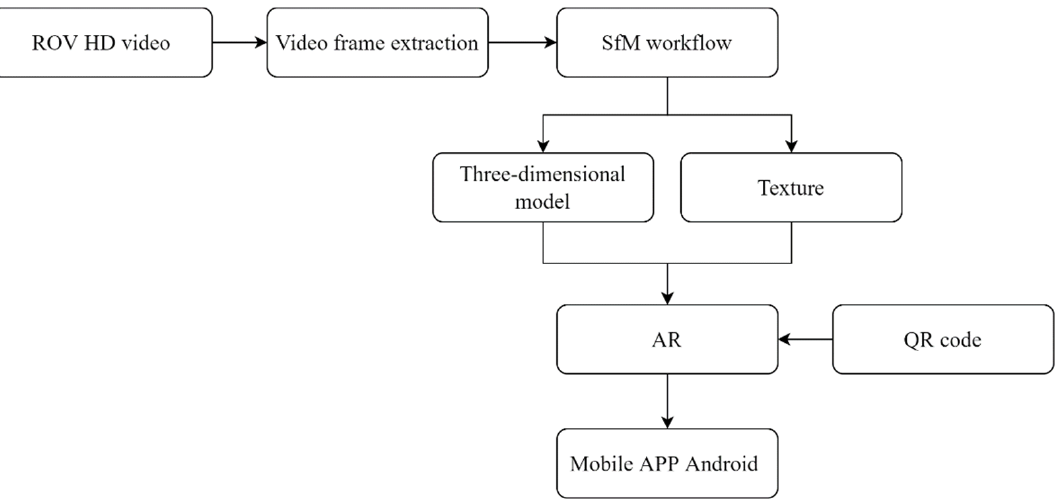
Figure 2. Generalised workflow of the methodology from the video acquisition to the APP development.